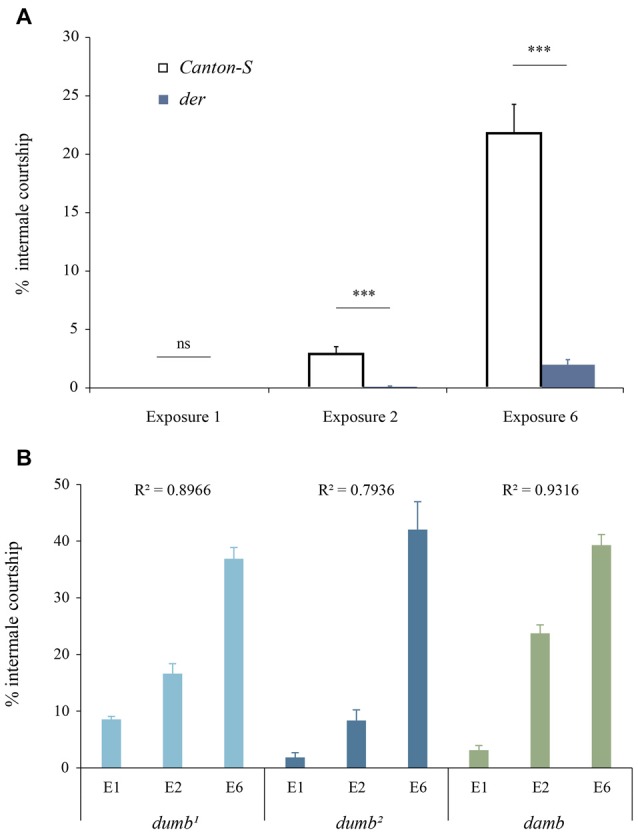
der mutant males exhibit impaired sensitization to the disinhibition effect of ethanol. (A)
der mutant males showed significantly reduced disinhibited courtship compared to the control Canton-S on the 2nd (exposure 2) and 6th (exposure 6) day of daily ethanol exposure (***p < 0.0001 by ANOVA and post hoc Tukey-Kramer HSD tests; Canton-S, n = 17; der, n = 19). ns, not significant. (B) dDA1 receptor mutants dumb1 and dumb2 as well as DAMB receptor mutant damb developed normal behavioral sensitization to the ethanol-induced disinhibition. (dumb1, p < 0.0001, n = 7; dumb2, p < 0.0001, n = 7; damb, p < 0.0001, n = 6). E, exposure.